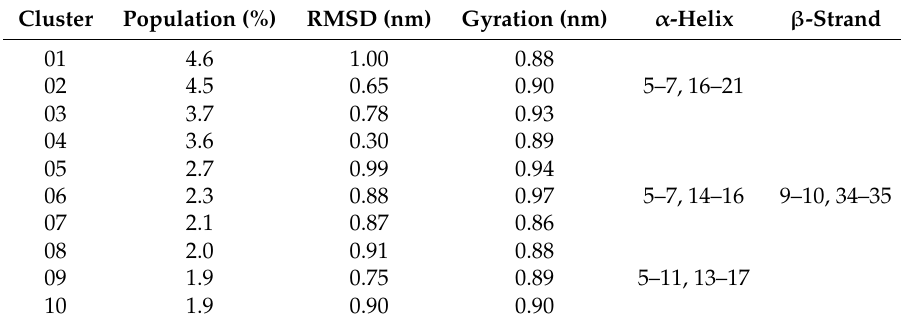
Table 1. Structural characteristics of the 10 most populated clusters of the non-amidated hIAPP found by REMD simulations. The RMSD are calculated relative to the initial random coil conformation.